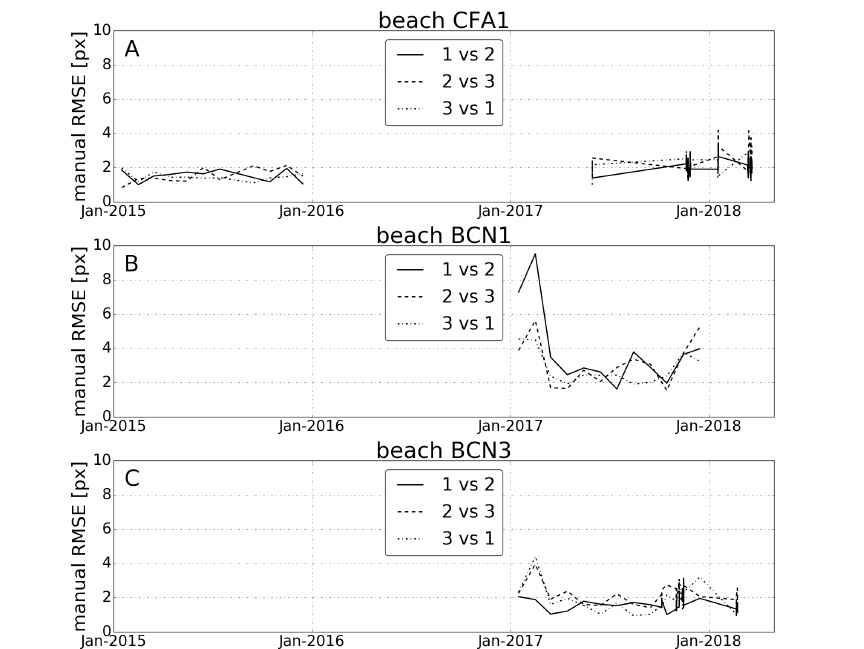
Figure 8. Root Mean Square Error (RMSE)—RMS distance between users—in pixels (2 px = 1 m) between the manual shorelines digitized by the three expert users in the different dates of beaches ( A ) CFA1, ( B ) BCN1 and ( C ) BCN3. Table 3. Global actual Root Mean Squared Error (RMSE) and bias (in meters and including all the studied dates), together with success percentage of the combined shorelines and the filtered shorelines, using no threshold for the self-computed errors and with thresholds of 20 and 10 px (the same threshold is applied to the combined and the filtered shorelines). Bold numbers indicate the recommended configuration. The RMSE of the manually digitized shorelines for each beach is also given in the last